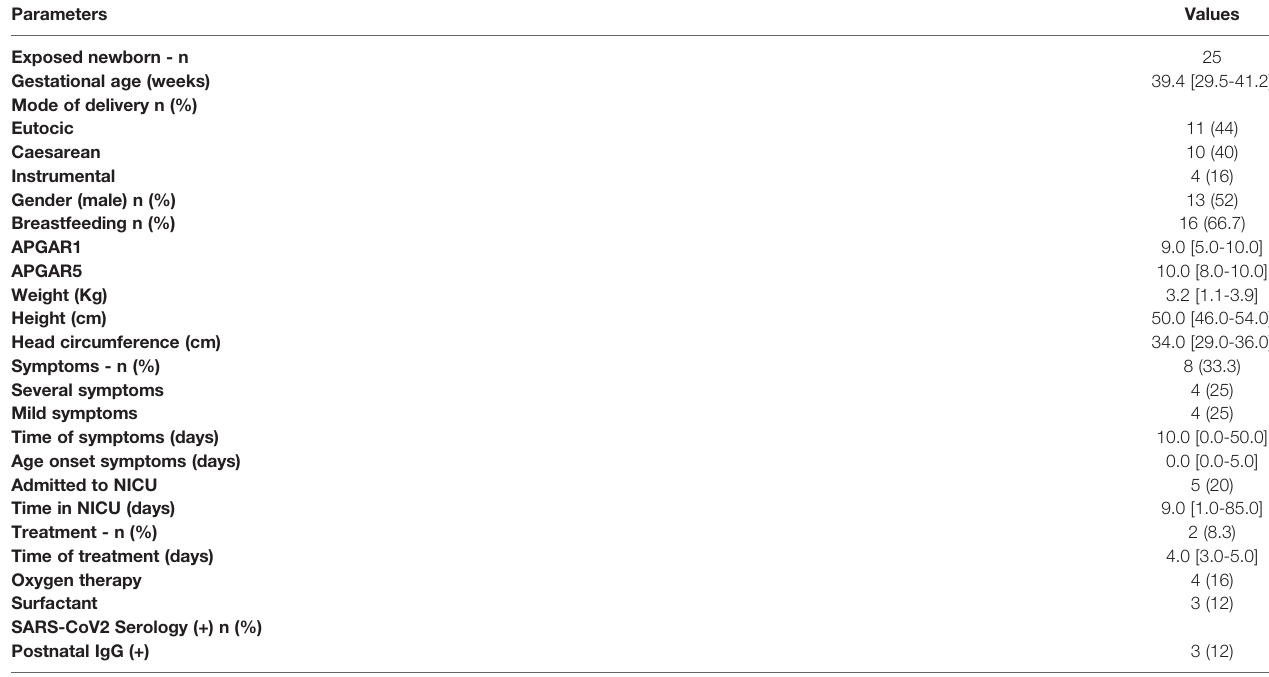
TABLE 2 | Exposed SARS-CoV2 newborns ’ characteristics. Parameters Values Exposed newborn - n